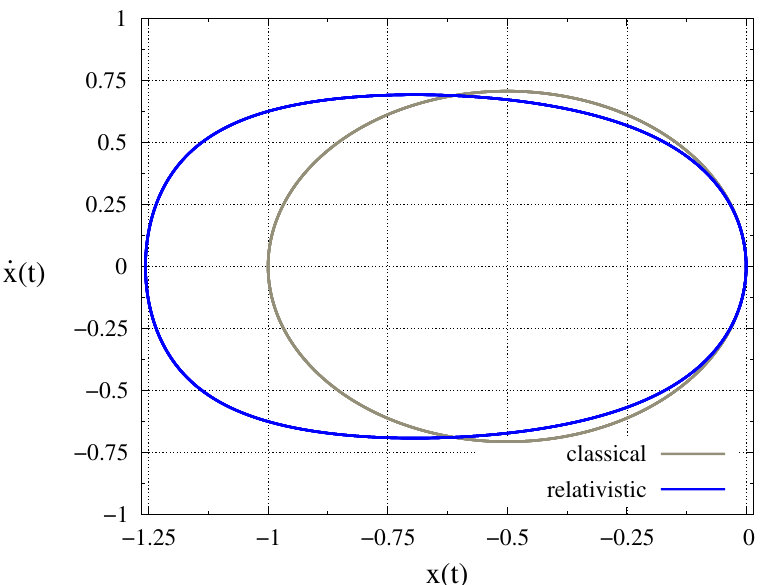
Figure 5. The phase-space diagrams for the harmonic oscillator in a uniform gravitational field corresponding to the classical and the relativistic case. We are using the same parameters as in Figure 2. The characteristics for both cases are similar: the closed trajectories represent periodic solutions, and their phase portraits represent center stable